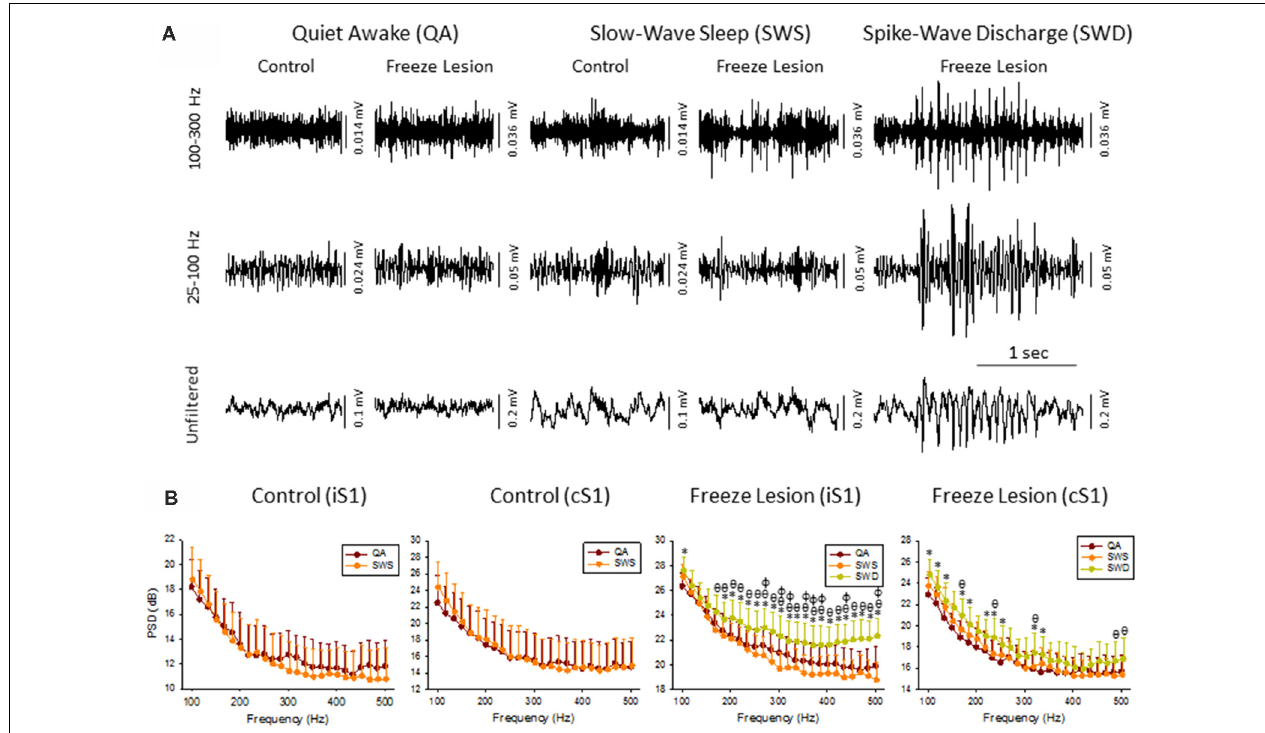
FIGURE 2 | High frequency oscillations (HFOs) across vigilance state and during SWD. (A) Sample LFP recordings of quiet awake (QA), slow-wave sleep (SWS), and SWDs in control and FL animals (iS1 recordings). Digital filtering of the field potential recordings revealed that SWDs were associated with an increased in HFOs (upper traces) as compared to the full spectrum recordings (lower traces). (B) Comparison of spectral power (i.e., PSD) levels across vigilance state and during SWDs in control ( n = 5) and FL ( n = 5–10) animals. ∗ P < 0.05 SWD vs. QA, θ P < 0.05 SWD vs. SWS, φ P < 0.05 QA vs. SWS (Holm-Sidak post hoc